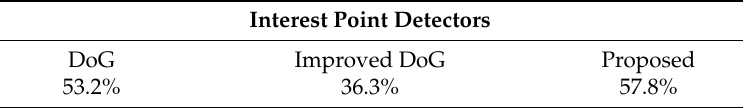
Table 1. Repeatability rate of interest points detected by different